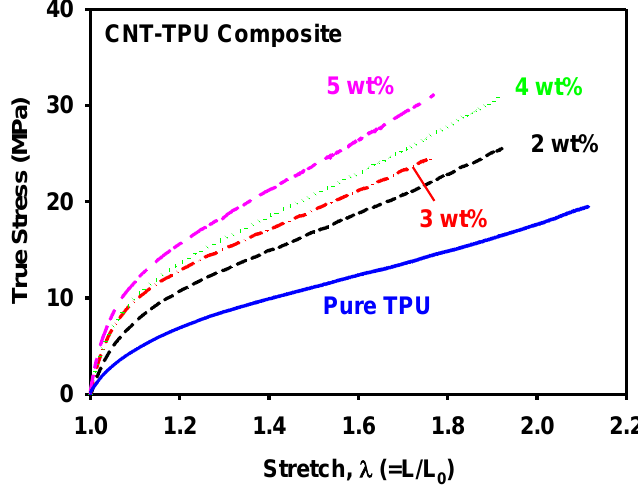
Figure 6. True stress-stretch curves of the MWCNT / TPU composites.